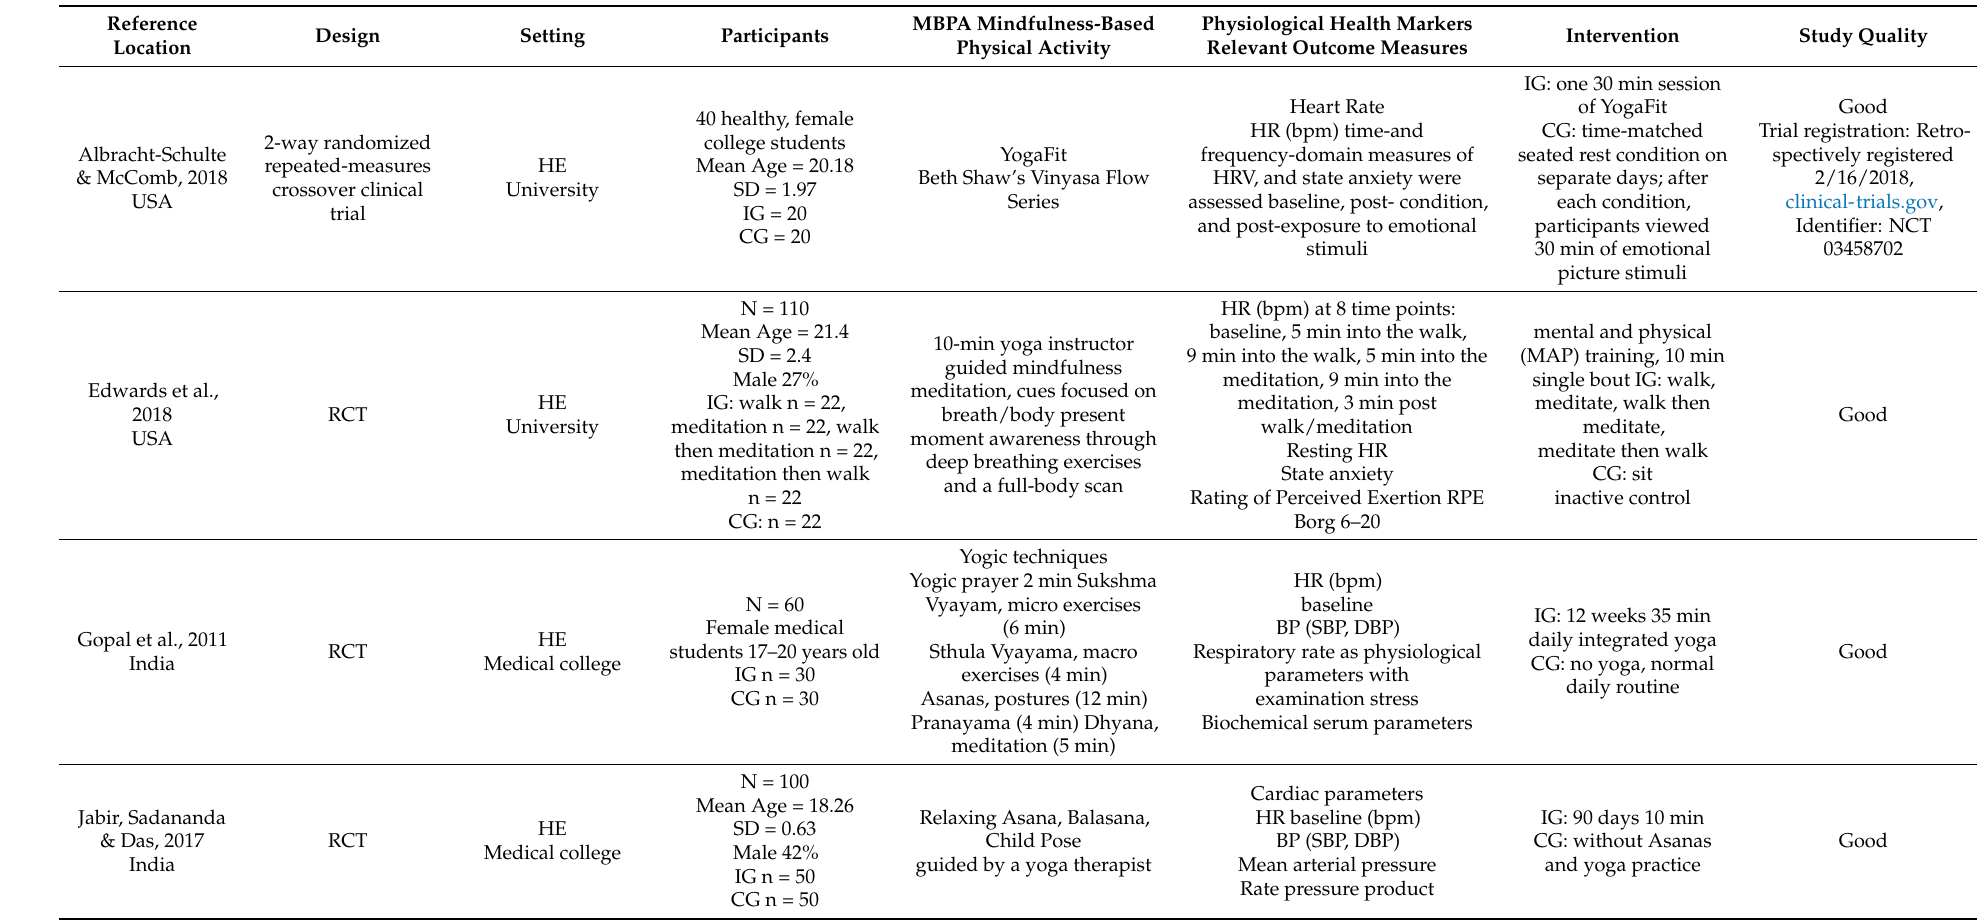
Table 1. Summary of Characteristics of the Included